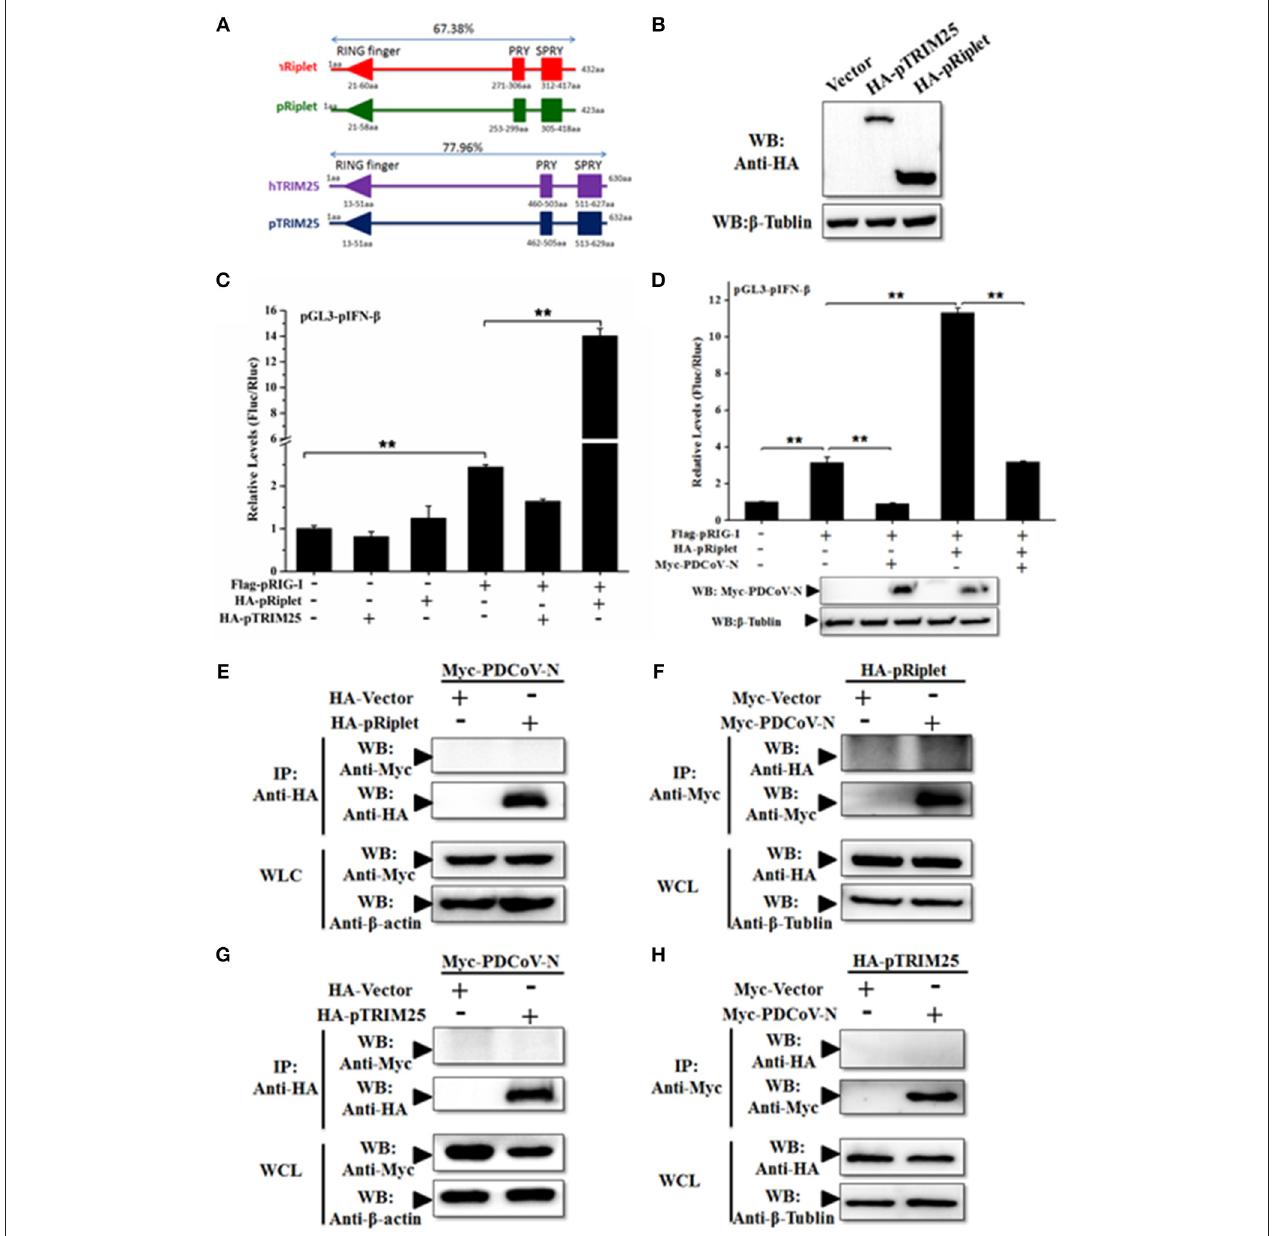
FIGURE 6 | PDCoV N repressed porcine Riplet-induced pRIG-I activation. (A) The sequence alignment of porcine TRIM25 (pTRIM25) and Riplet (pRiplet) with human TRIM25 (hTRIM25) and Riplet (hRiplet), respectively, by Clustal Omega (https://www.ebi.ac.uk/Tools/msa/clustalo/). (B) HEK293T cells were transfected with the HA-tagged pTRIM25 or HA-tagged pRiplet expression plasmid. After 28h of transfected, the WCLs were detected with anti-HA antibody by western blot. (C) PK-15 cells were co-transfected with pRIG-I, pGL3-pIFN- β , and pRL-TK plasmid with pTRIM25 or pRiplet, the empty plasmid as the control. Dual-luciferase assays were performed at 24h post transfection. (D) PK-15 cells were co-transfected with pRIG-I, pGL3-pIFN- β , and pRL-TK plasmid with pRiplet and Myc-PDCoV-N, the empty plasmid as the control. Dual-luciferase assays were performed at 24h post transfection. All the experiments were independently performed three times. (E,G) HEK293T cells were cotransfected with HA-tagged pRiplet or HA-tagged pTRIM25 or HA-empty plasmid as the control with Myc-tagged PDCoV-N expression plasmid, respectively. (F,H) HEK293T cells were co-transfected with Myc-tagged PDCoV (Myc-PDCoV-N) or Myc-empty plasmid as the control expression plasmid with HA-tagged pRiplet (F) or HA-tagged pTRIM25 (H) plasmid, respectively. After 28h of transfection, the cells were lysed for Co-IP with anti-Myc monoclonal antibody (IP: Anti-Myc). Western blot was used to detect the immunoprecipitants and WCLs protein. ** p < 0.01. To further understand the mechanism of PDCoV N protein- plasmid in HEK293T cells for 28 h. The Co-IP results showed that PDCoV N protein could bind to both the HEL and RD domain binding pRIG-I, three pRIG-I mutants expression plasmids or but not the 2 ′ CARD domain ( Figure 7F ). The binding empty plasmid was co-transfected with PDCoV N expression